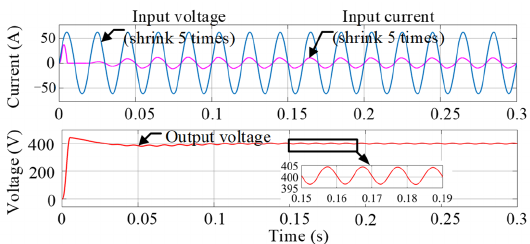
Figure 18. Simulation waveform of pre-stage.